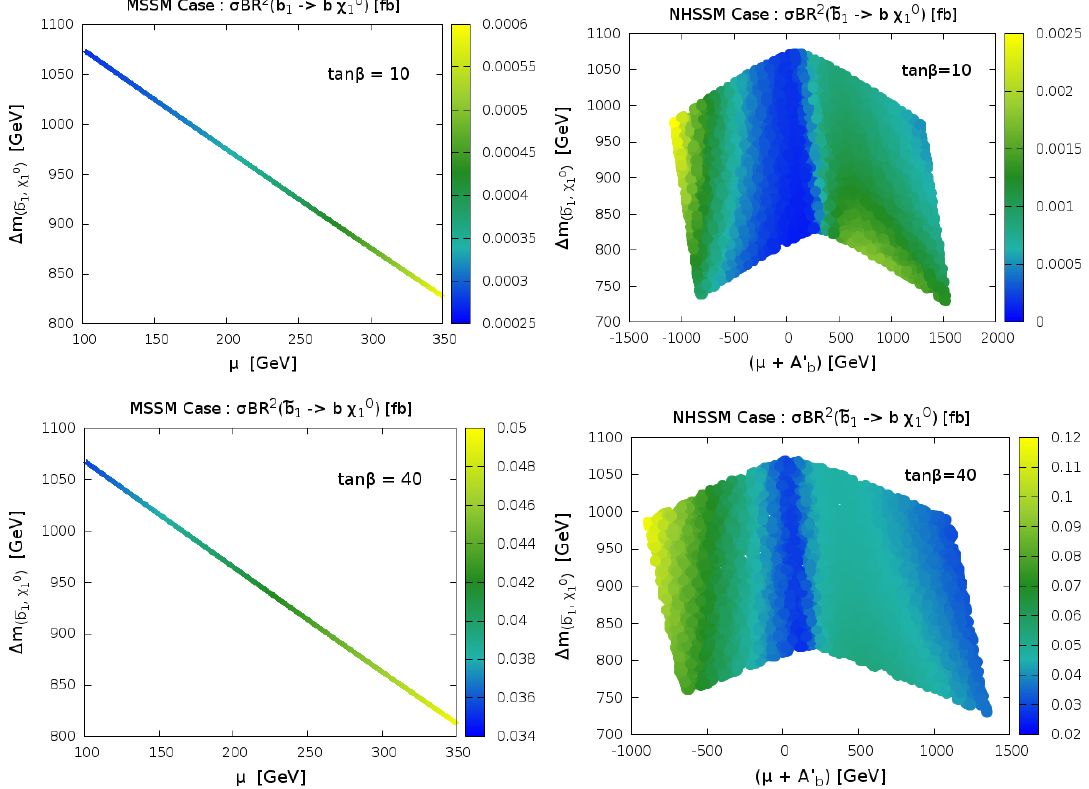
BR[~ b 0 ] 2 ) in the (cid:12)nal state 2 b + =E 1 ! b(cid:31) 1 b 1 ~ b 1 (cid:2) , for the plots on right) and the resulting mass-split b . Other (cid:12)xed parameters are: (cid:22) = 200 GeV, M 1 = 500 GeV, b 1 ;(cid:31) 0 1 ) = m ~ =1.2 TeV and (cid:22) 0 = b L b R